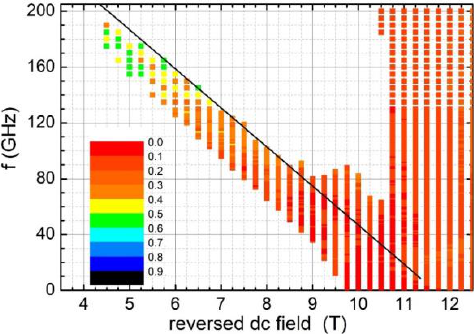
Figure 1. Conditions (exciting frequency vs. applied reversed field) under which reversal occurs within 1 ns for a CoPt disk with diameter D = 16 nm and thickness t = 4 nm. The color code represents the switching time in nanoseconds. A particular color is used for switching time, which is between the values indicated at its two edges. The solid black line represents the Kittel condition 𝑓 = 𝛾 (11.7 𝑇 − 𝐻) . The points corresponding to conditions for which magnetization reversal occurs within 1 ns are denoted. These points fall below a straight line corresponding to the fer- romagnetic resonance (FMR) frequencies given by the Kittel condition 𝑓 = 𝛾 ( 𝐻 dc − 𝐻 ) , where H dc is the coercivity without MAS. The color code represents the time of the rever- sal. For this disk geometry, the demagnetization factor along the z direction is N = 0.7341. For a hard phase with anisotropy K mc and saturation magnetization M S , the coherent rota- tion coercivity is given by the relation: For the used parameters of the CoPt, this is expected to be H dc = 11.7 T, which agrees with the data of Figure 1.